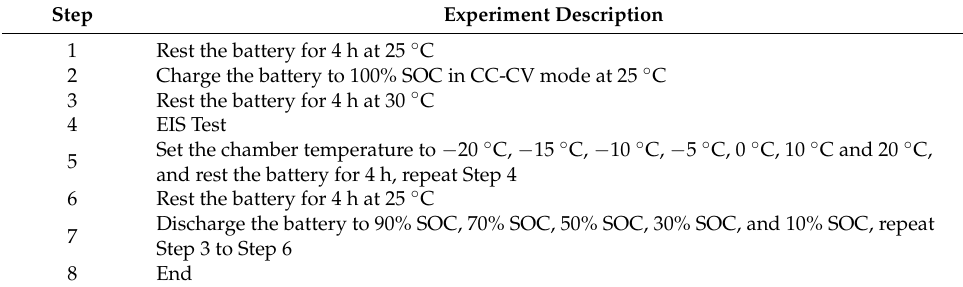
Table 1. EIS experiments without the temperature gradient. CC-CV: constant current-constant voltage.